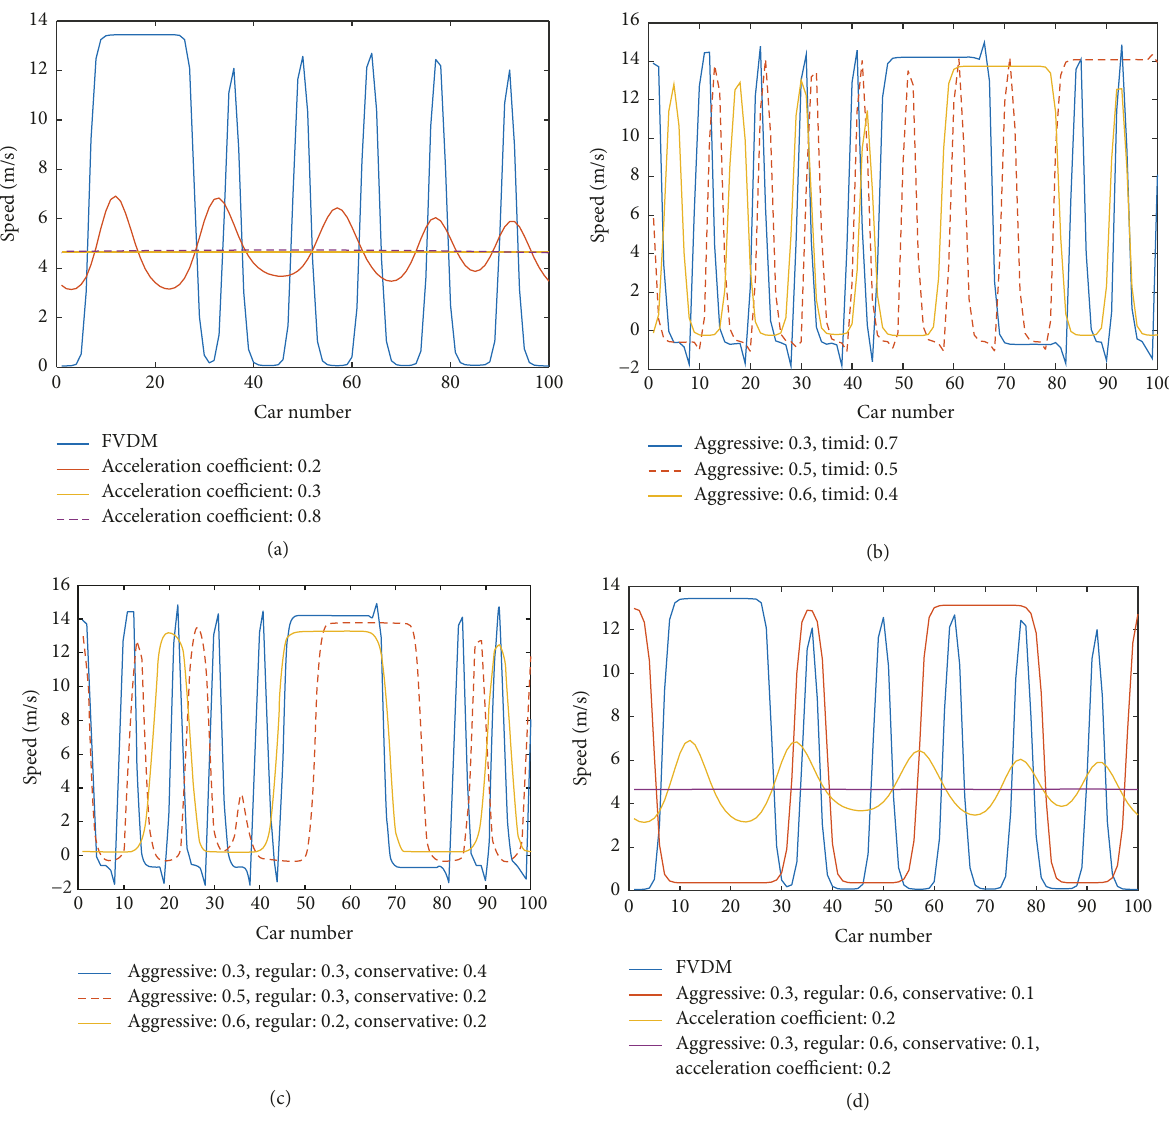
Figure 8: Snapshot of the velocities of all vehicles (a) at different response coefficient to the acceleration of preceding vehicle (b) with two different driving characteristics and (c) with three different driving characteristics and (d) at different parameters in the proposed model when 𝑡 = 1000 s ( 𝜆 = 0.45 , 𝑝 1 = 0.2 , 𝑝 2 = 0.05 , and 𝑝 3 = −0.2